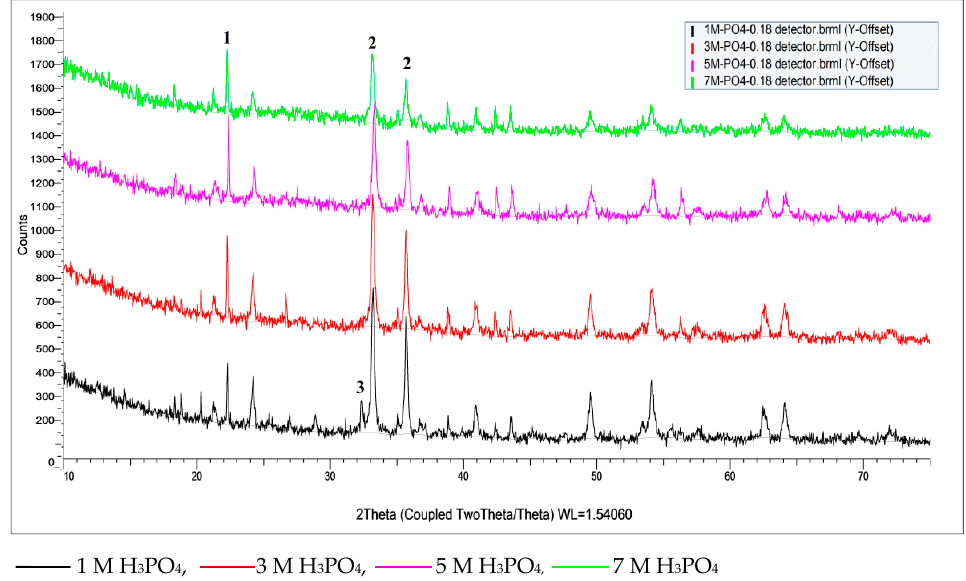
Figure 7. Effect of acid molarity on mineralogical composition of the precipitates (1: Diaspore, 2: Hematite, 3: Ca 2 SiO 4 ).